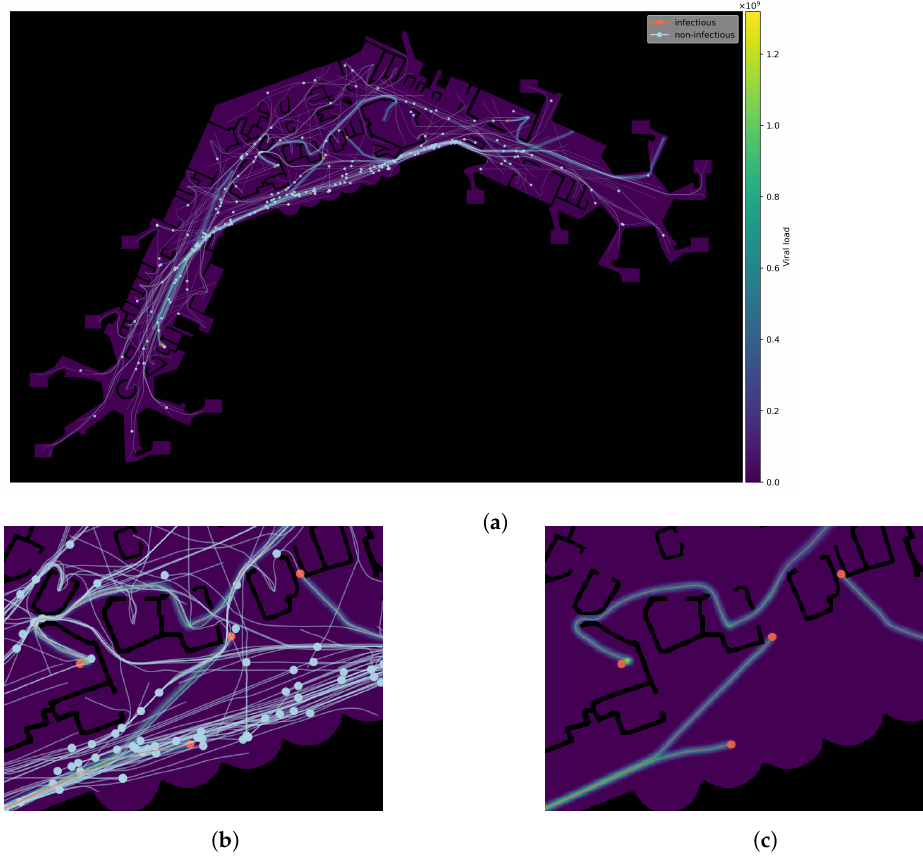
Figure 5. Detail view of trajectories and aerosol trail generation. ( a ) Exemplary agent trajectories and aerosol trail generation. ( b ) Detail view with agents, trajectories, and aerosol traces. ( c ) Detail view showing only infectious agents and traces.